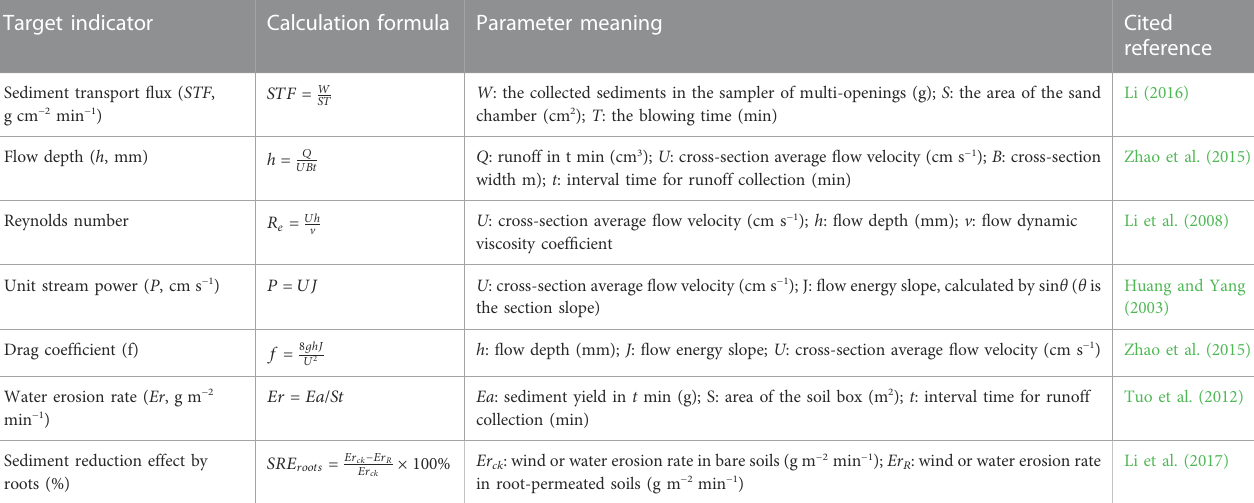
TABLE 2 Measured and calculated indicators in simulated wind tunnel – rainfall